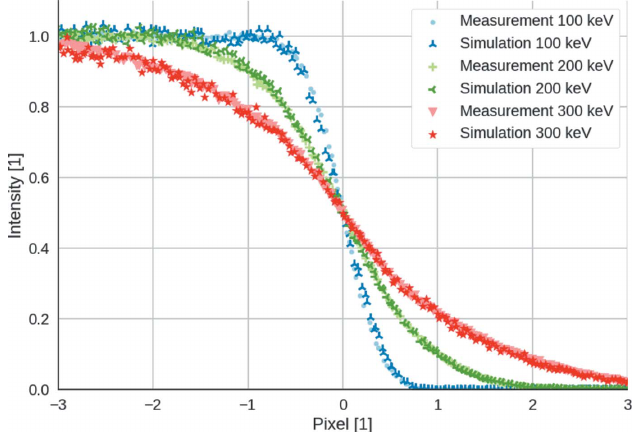
Figure 6 Comparison between the measured and simulated edge for 60 keV threshold.